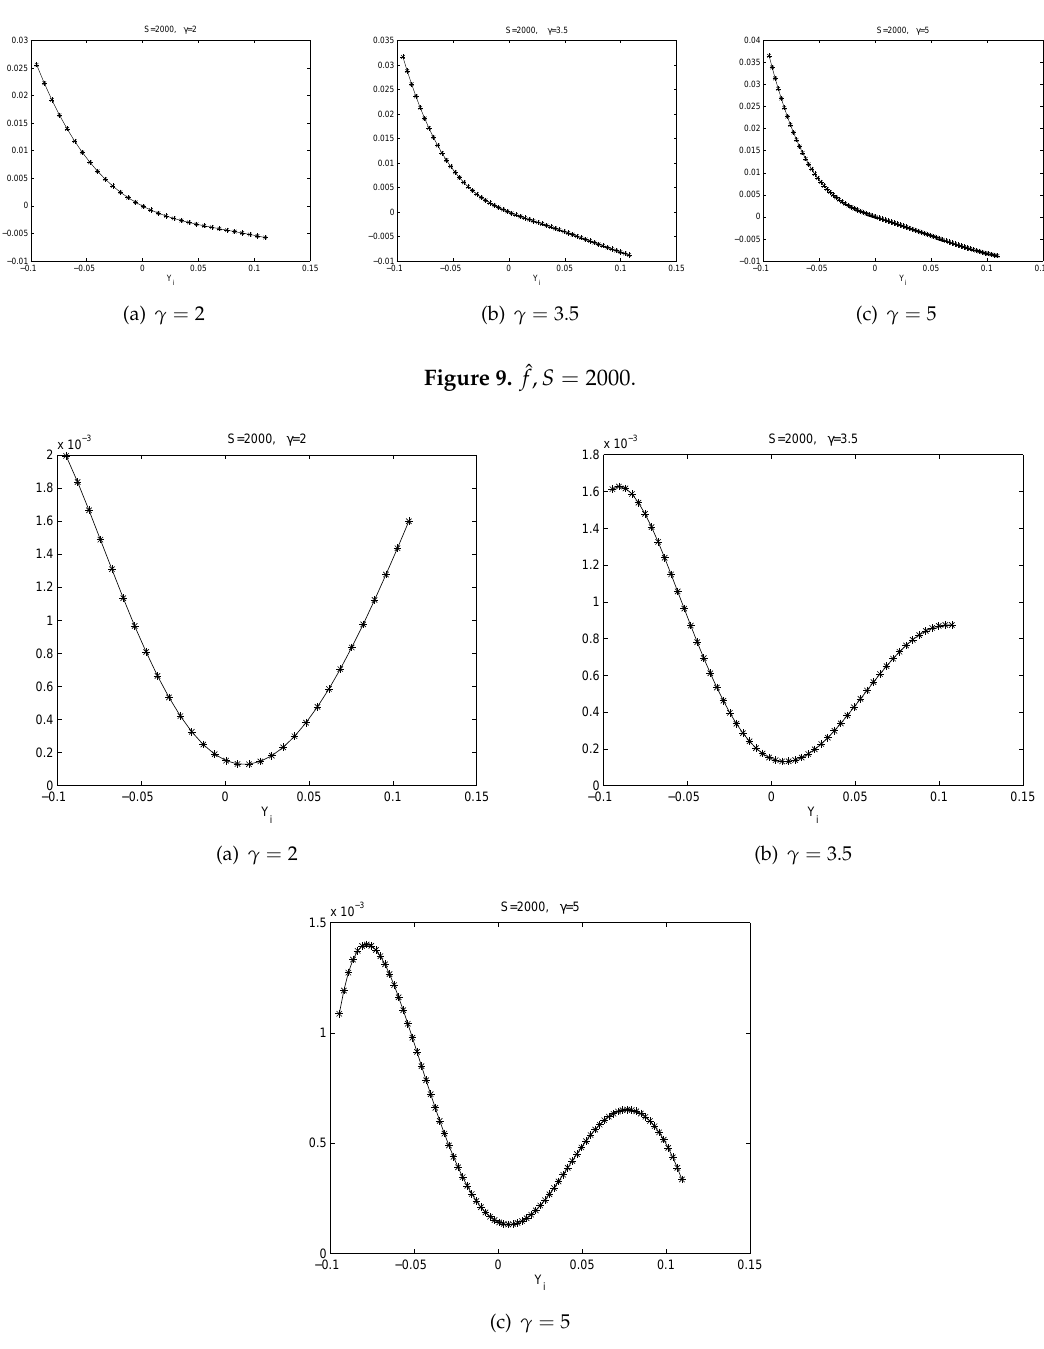
Figure 10. ˆ g 2 , S =